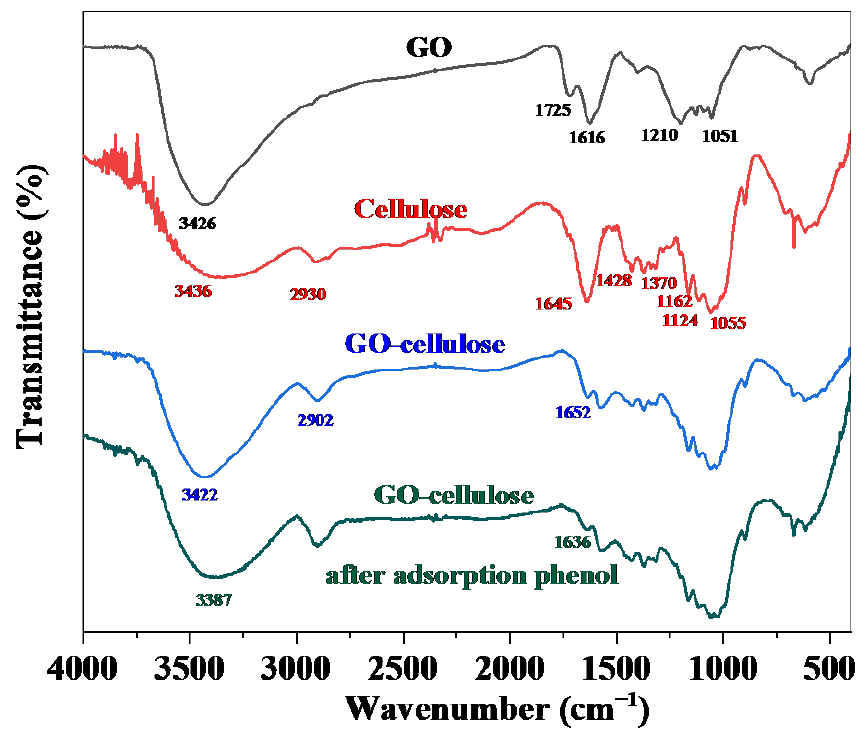
Figure 1. FTIR spectra of GO, extracted cellulose, and GO–cellulose composite.